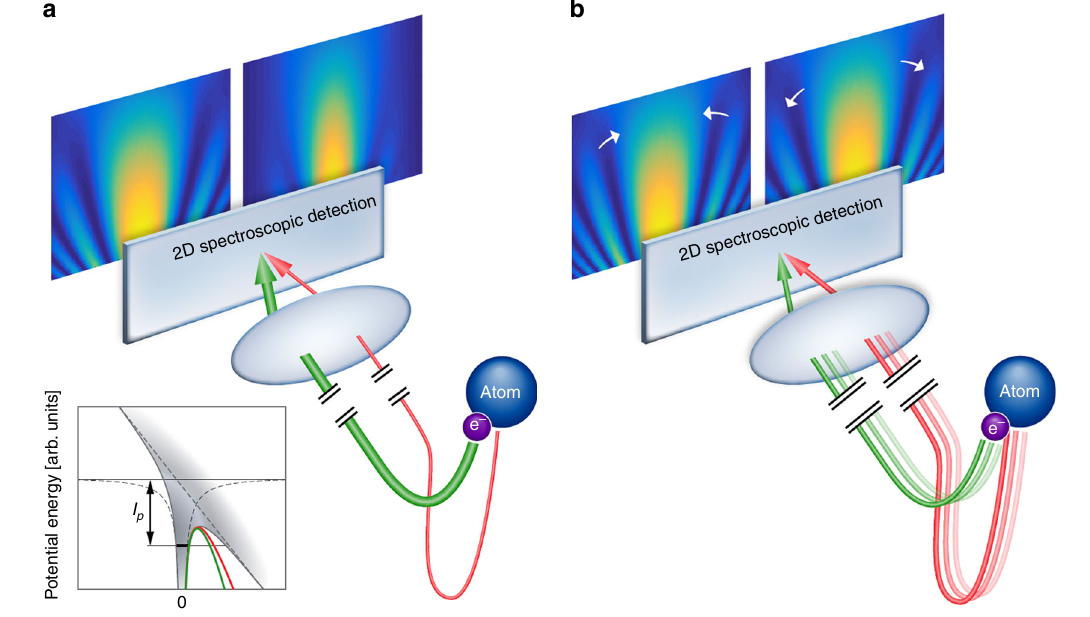
Fig. 1 Perturbing the dynamics in photoelectron holography. The velocity map imaging (VMI) spectrometer maps direct (green) and rescattered (red) photoelectron trajectories with the same fi nal momenta onto the same point of a position-sensitive detector. a The effect of the second harmonic on the amplitude of the electron trajectories causes the contrast of the interference pattern to vary with the two-color delay. Inset: Due to their different ionization times, the signal and reference electron trajectories experience different tunneling barriers, indicated by the green and red curves. b The effect of the SH on the phase gained along the electron trajectories in the continuum causes the positions of the interference peaks and dips to shift with the two-color